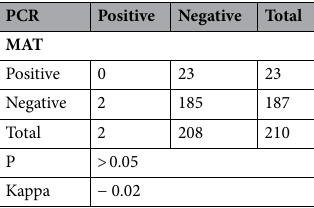
Table 4. Relationship between the results of MAT and PCR in